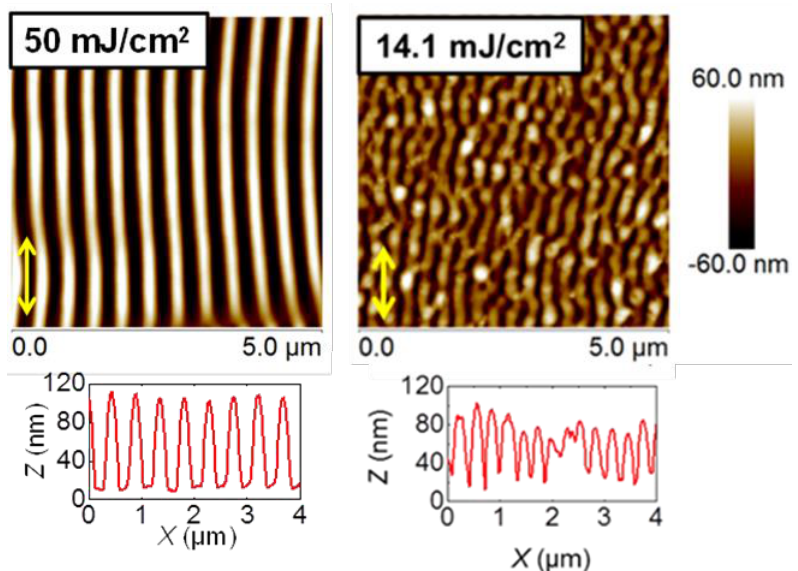
Figure A1. Comparative AFM height images of LIPSS obtained on P3HT thin films with 3600 pulses at 532 nm (fluence of 50 mJ/cm 2 ) and at 266 nm, fluence of 14.1 mJ/cm 2 . Horizontal height profiles over lengths of 4 µm are shown at the bottom of each image. The polarization vector of the laser beam is indicated by double arrows ( ↔ ).